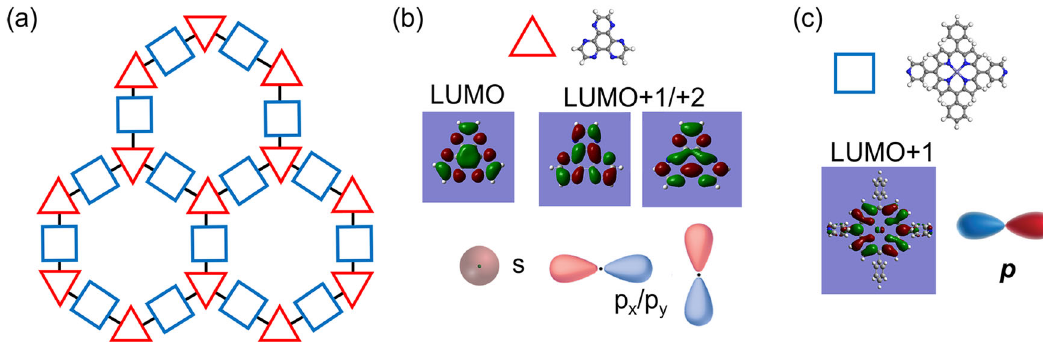
ð Fe (cid:2) DPyP Þ 3 , 2